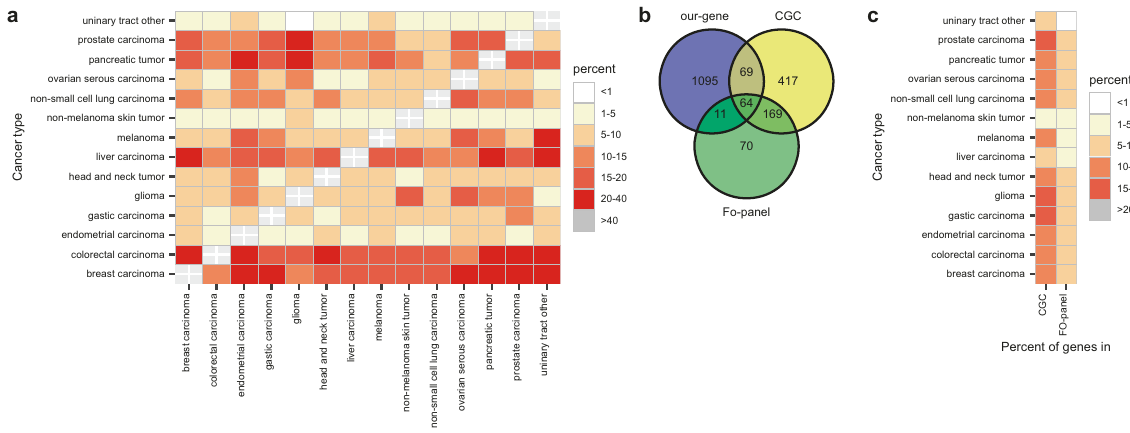
Fig. 3 Gene overlap between panels. a Percentage of shared genes between the panels for TMB prediction based on “ our gene-set ” . b Euler- Venn diagram of genes in the panels for TMB prediction based on “ our set ” , CGC genes and genes in the FO-panel. c Percentage of shared genes between panels for TMB prediction, CGC and FO-panel, per cancer